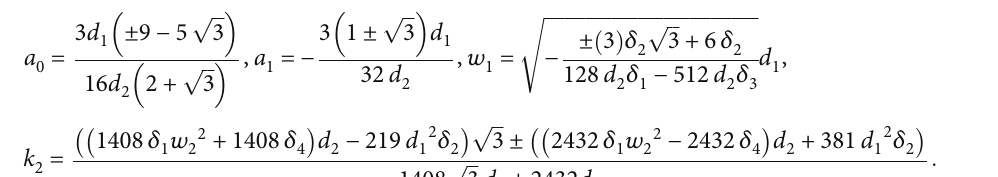
Figure 8: The graphical simulation representation of j U 9 = 0 : 6, w = 0 : 01 δ 4 2